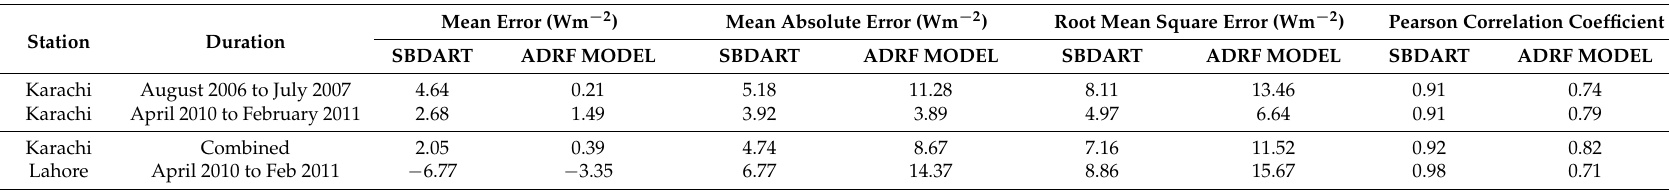
Table 11. Comparative statistical evaluation of ADRF model and Santa Barbara DISTORT Atmospheric Radiative Transfer (SBDART) model estimated monthly ADRF at Karachi and Lahore in the